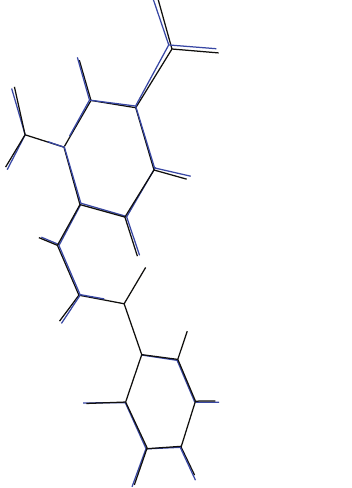
Figure 3: Atom-by-atom superimposition of the structures calcu- lated (blue) by B3LYP/6-31G on the X-ray structure (black) of the title compound.